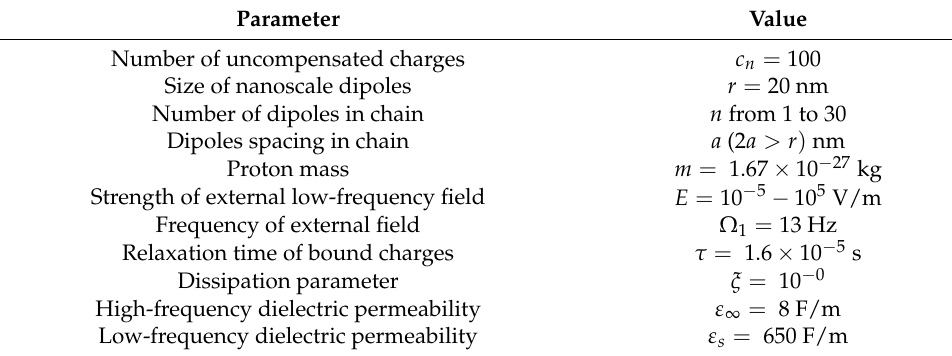
Table 1. Parameters used in the model.